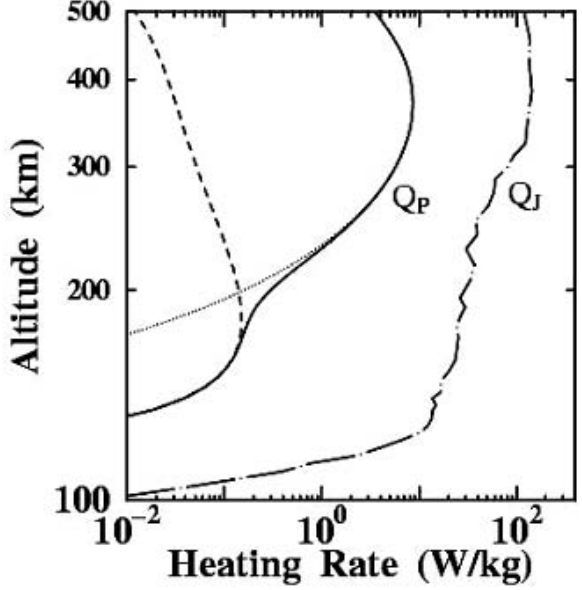
Fig. 9. The calculated heating rates (W/kg) due to precipitating electrons (dotted line), protons (dashed line), both particles (solid line labeled Q P ) , and σ pE 2 / ρ at 09:10 UT derived from the ESR observations (dashed-dotted line labeled Q J )